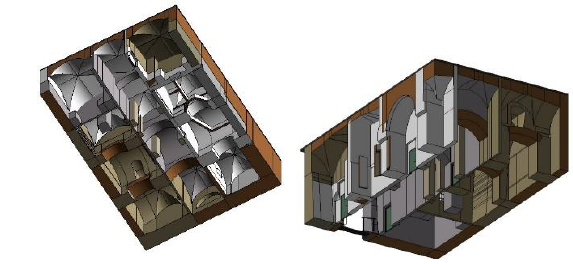
Figure 7. View of the